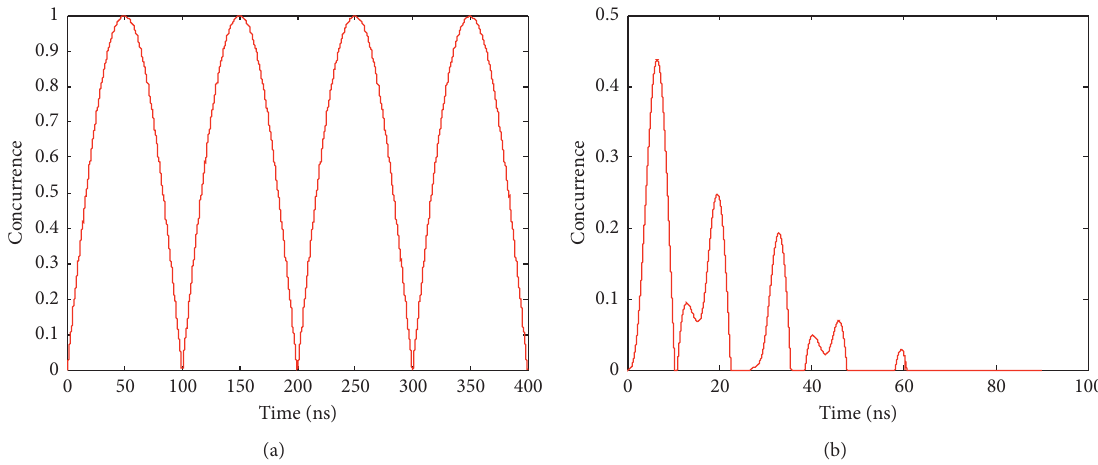
Figure 3: (a) Concurrence of the coupled system in pure situation. (b) Concurrence of the coupled system with